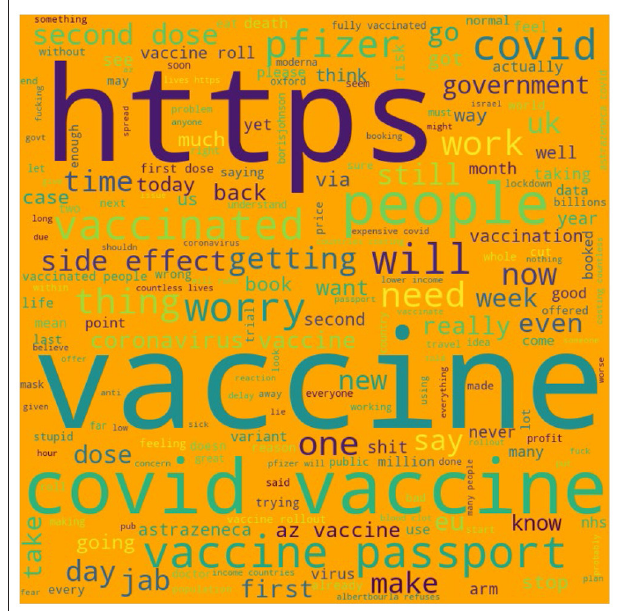
FIGURE 2 | Visual representation of the most commonly discussed topics within the dataset.